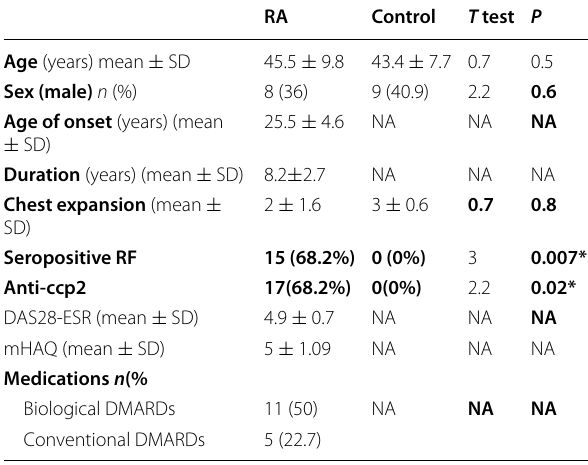
0.001) (Tables 2, 3, 4 and 5).